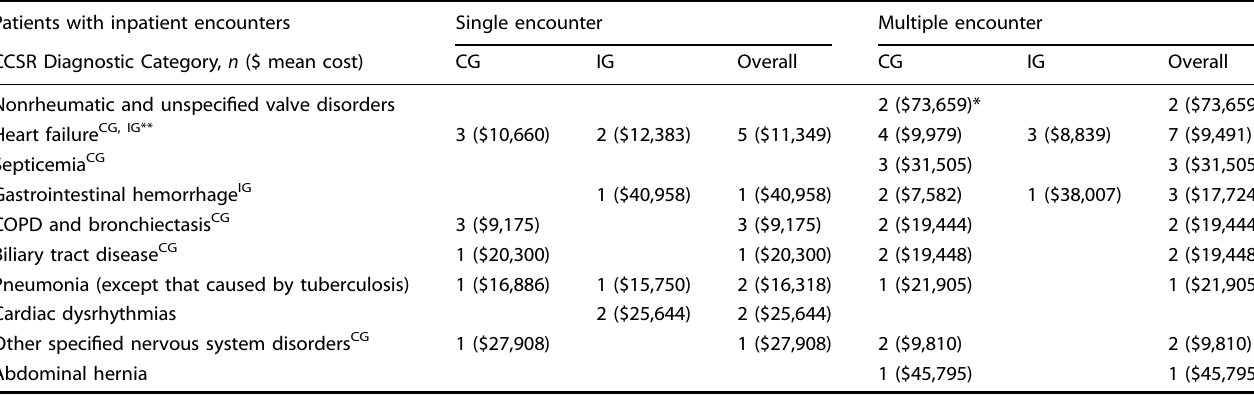
Table 5. Top 10 most expensive inpatient encounters grouped by diagnostic categories.